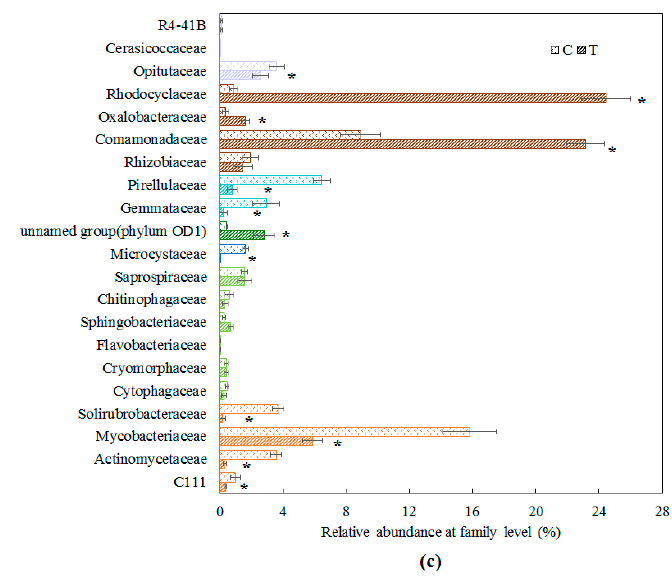
Figure 1. ( a ) Change of bacterial community composition at the phylum level in the controls (C) and water hyacinth treatments (T) over time. ( b ) Comparison of 10 bacterial phyla with relatively higher abundance between the controls (C) and the water hyacinth treatments (T) at day 30; ( c ) Comparison of 21 major families between the controls (C) and the water hyacinth treatments (T) at day 30. Asterisks were marked in histograms to indicate significant differences ( p < 0.05) between the controls and the treatments. The same colored label showed the same phylum or the family in the same phylum.